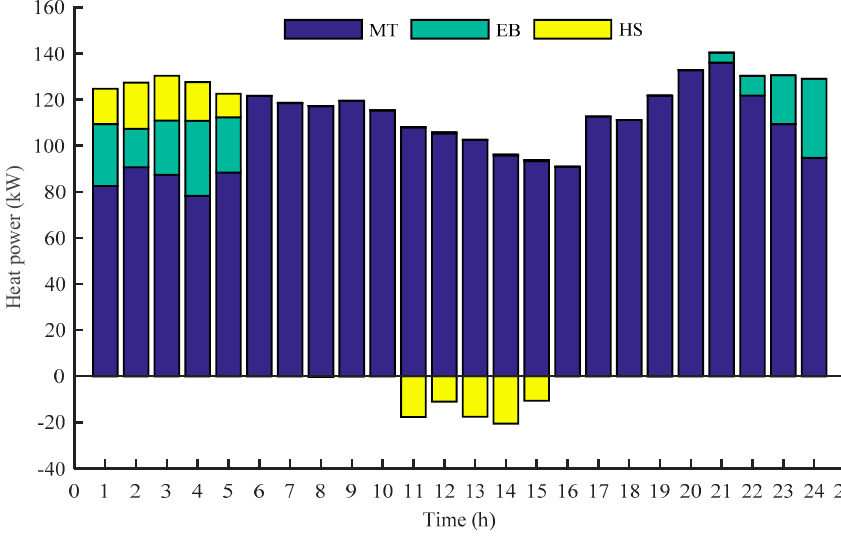
Figure 12. Results of electric power.